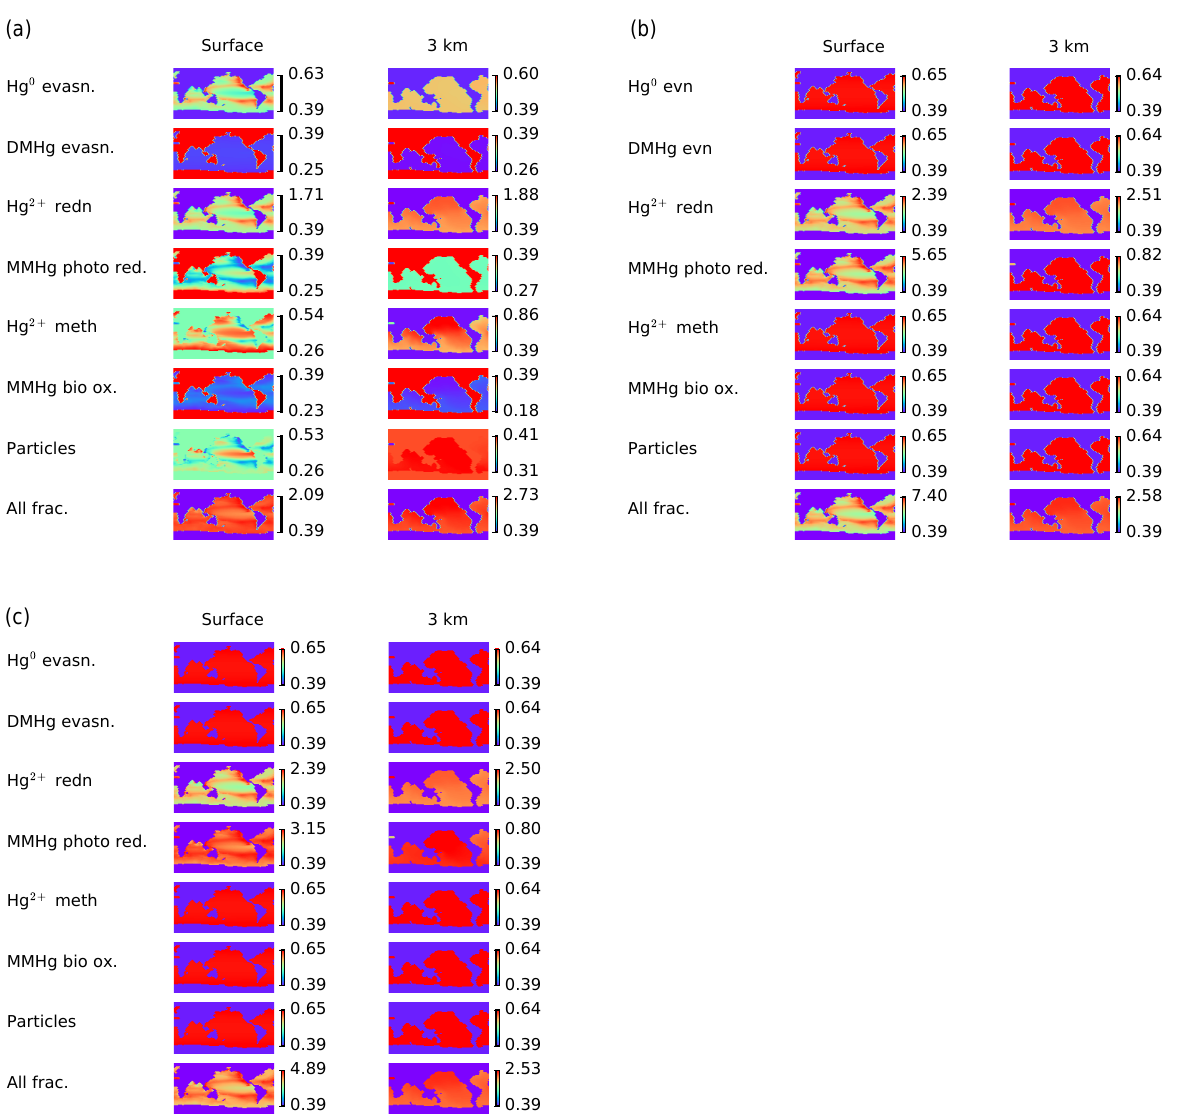
Figure 13. (a) Maps of δ 202 Hg(II) at the sea surface (left) and at 3km depth (right) for different fractionation scenarios. (b) Maps of (cid:49) 199 Hg(II) at the sea surface (left) and at 3km depth (right) for different fractionation scenarios. (c) Maps of (cid:49) 199 Hg of MMHg at the sea surface (left) and at 3km depth (right) for different fractionation